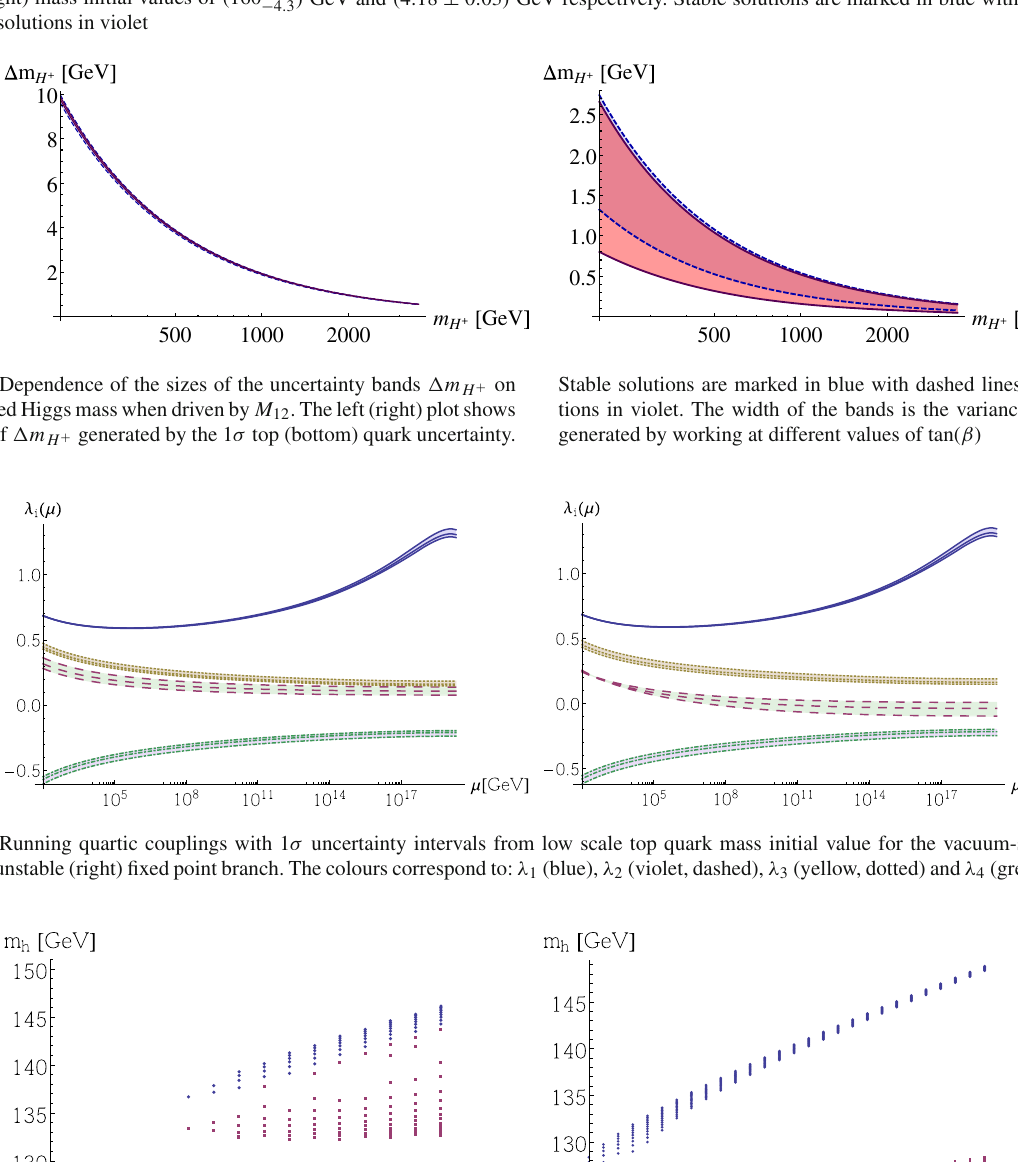
Fig. 10 Masses of SM-like CP-even Higgs boson evaluated at M 12 = 380 GeV with 1 σ uncertainty regions from top quark (left) and bottom ) GeV and ( 4 . 18 ± 0 . 03 ) GeV respectively. Stable solutions are marked in blue with dashed outline, quark (right) mass initial values of ( 160 + 4 . 8 − 4 . 3